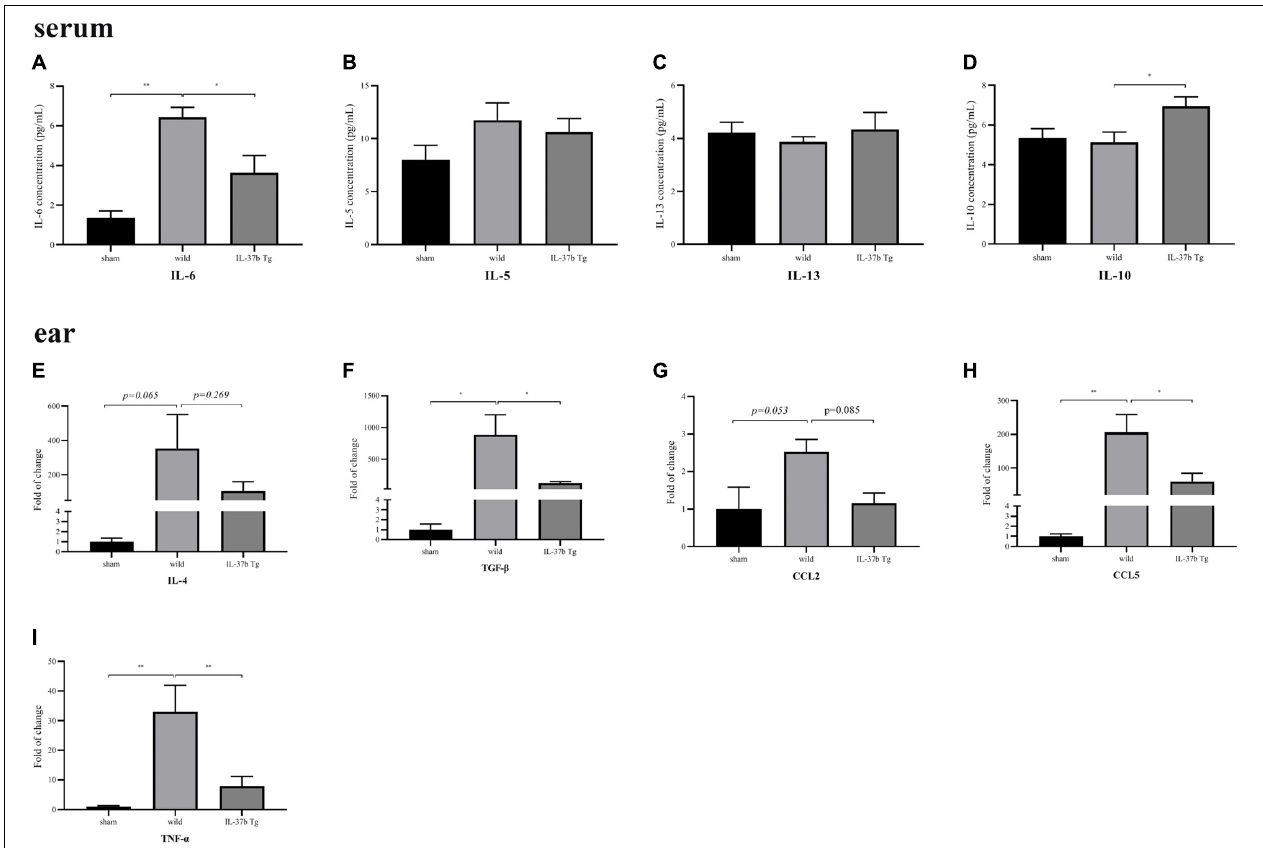
FIGURE 2 | In vivo effect of IL-37 on the production of cytokine and chemokine in AD mice. Serum level of (A) IL-6, (B) IL-5, (C) IL-13, (D) IL-10, and mRNA expression of (E) IL-4, (F) TGF- β , (G) CCL2, (H) CCL5, and (I) TNF- α of wild type and IL-37b Tg mice upon MC903 stimulation. Bar charts are shown as mean ± SEM ( n = 6 mice). * P < 0.05 and ** P < 0.01 when compared between the denoted